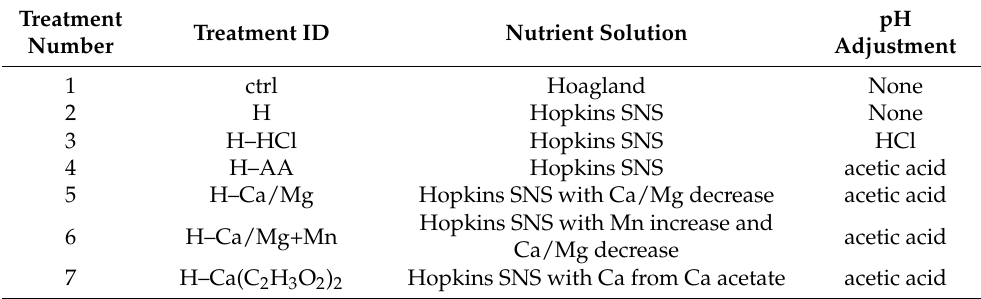
Table 1. Treatments for a soybean hydroponic nutrition study. The acids for pH adjustment were at 1.1 and 1.8 M for hydrochloric (HCl) and acetic (AA) acids, respectively. When noted, the Mn increase was 25%, Ca decreased 21%, and Mg decreased 73% compared to the standard Hopkins (H) or single-nutrient source (SNS) solution (see Table 2 for concentrations for base Hopkins SNS and Hoagland